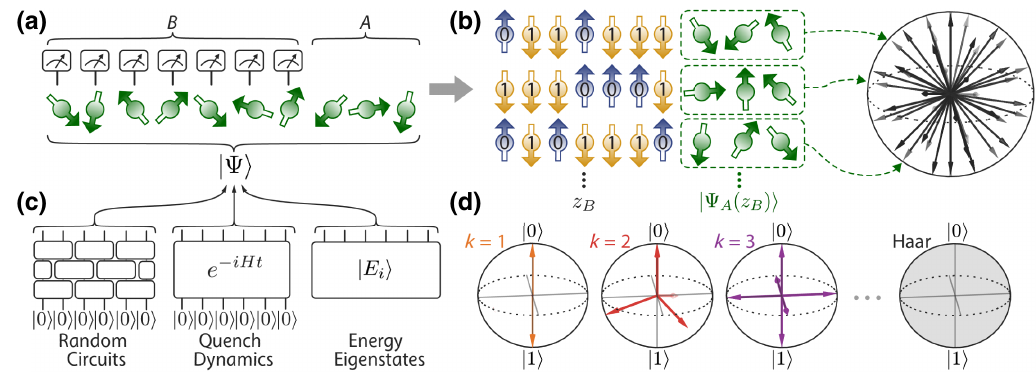
FIG. 1. The emergence of a universal quantum state ensemble from a single many-body wave function. (a) A subsystem B of a pure many-body wave function | (cid:2) (cid:2) is measured in a fixed local basis; the remaining unmeasured qubits in A are in a pure state that depends on the measurement outcome on B . (b) For quantum systems consisting of qubits, the measurement on B samples random outcomes, each characterized as a bit string z B (binary numbers in the blue and yellow arrows). Different measurement outcomes z B occur with probability p ( z B ) and lead to distinct quantum states | (cid:2) A ( z B ) (cid:2) , forming the projected ensemble E = { p ( z B ) , | (cid:2) A ( z B ) (cid:2)} . In the right panel, the ensemble of pure states | (cid:2) A ( z B ) (cid:2) (black arrows) is randomly distributed in the Hilbert space of A (black sphere), forming an approximate quantum state k -design. (c) Examples of many-body wave functions the projected ensembles of which form approximate quantum state designs include the typical output states of random unitary circuit evolution, quantum states obtained from quenched time evolution, and energy eigenstates of a chaotic Hamiltonian at infinite temperature. (d) An illustration of minimal quantum state k -designs for a single qubit on the Bloch sphere. The formation of higher k -designs requires a larger number of pairwise nonorthogonal quantum states. In the limit of k → ∞ , a k -design approaches the so-called Haar ensemble, which is the uniform distribution over all pure quantum